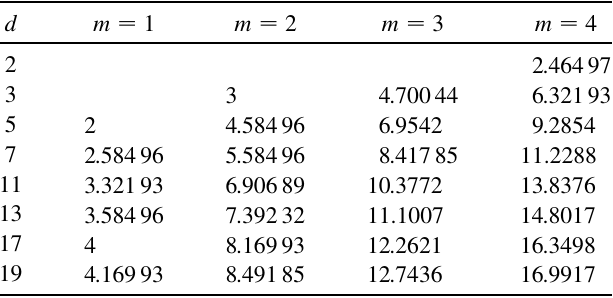
TABLE I. The yield-scaling parameter, (cid:8) (cid:7) , for distillation by QRM ð m Þ , as governed by Eq. (71). The smaller the value of d (cid:8) (cid:7) , the more resource efficient the protocol in the limit of many iterations. For qubit systems, the 10-to-2 protocol of Ref. [58] ð 5 Þ (cid:10) 2 : 321 93 , which is the best-known achieves (cid:8) (cid:7) ¼ log 2 value for qubit protocols. Empty cells indicate that no non- Clifford gate exists for those parameters.